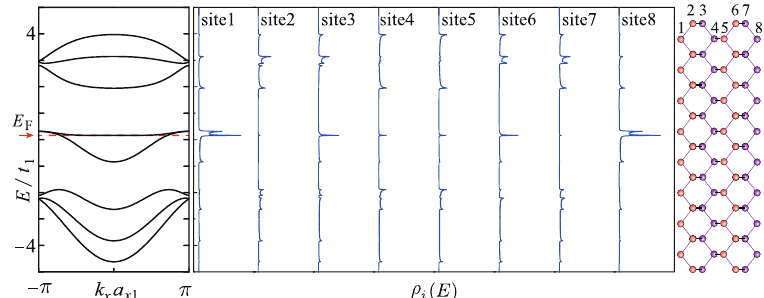
Figure 3. Dispersion relations E ( k x ) and the local density of state ρ i ( E ) of 4z-Q1D-PNR. The Fermi level E F = 0.24 t 1 is illustrated by the horizontal dashed red